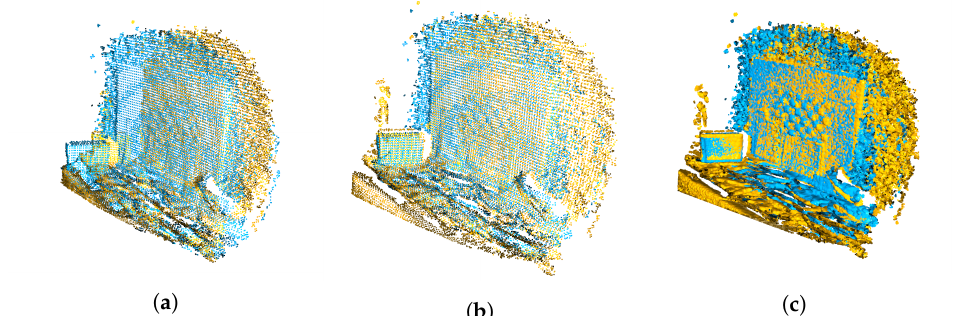
Figure 7. Visualizations of the registration of two point clouds, one shown in blue and one in yellow: ( a ) The point clouds before realignment, ( b ) after global registration, and ( c ) the refined local registration.